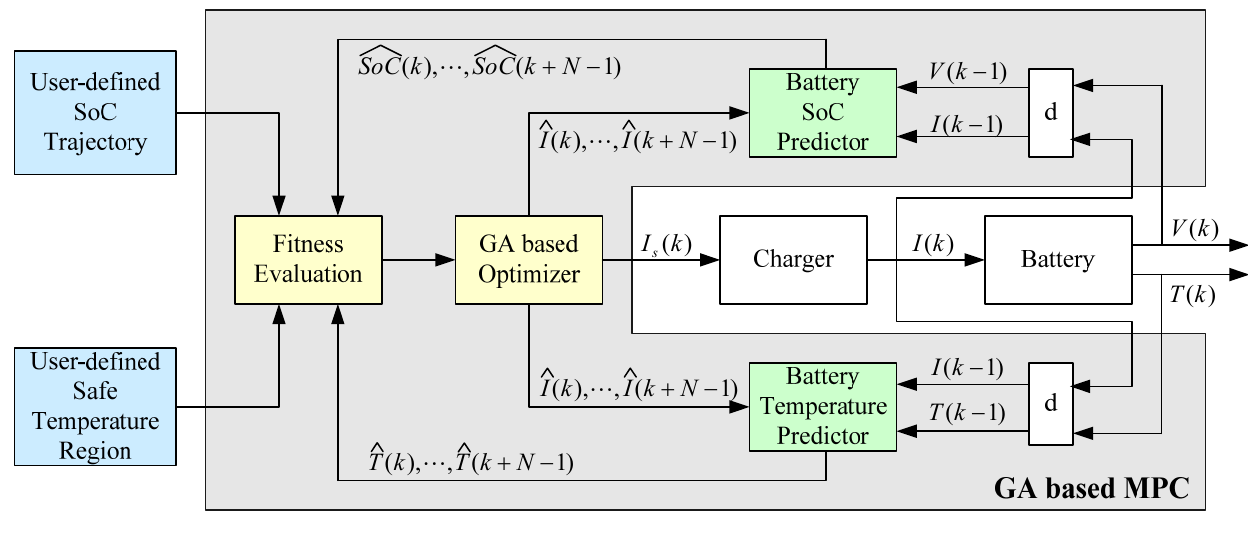
Figure 1. Fast charging control framework based on model predictive